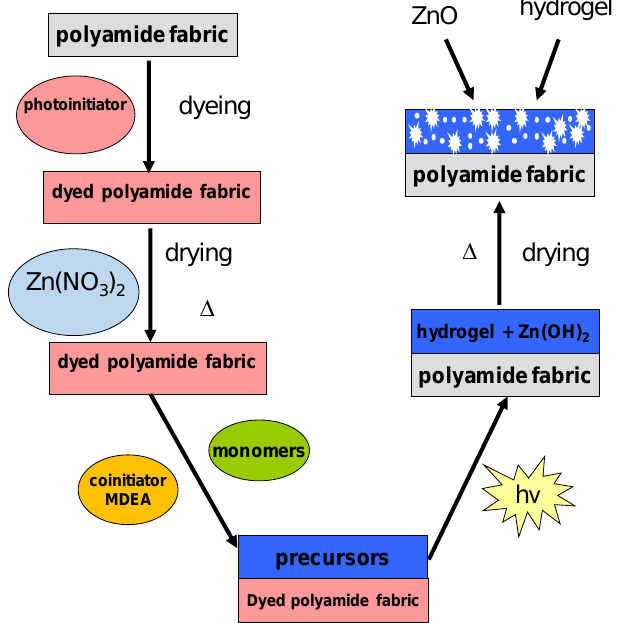
Figure 1. Routes to the preparation of a composite materials ZnO nanoparticles-hydrogel-polyamide fabric.